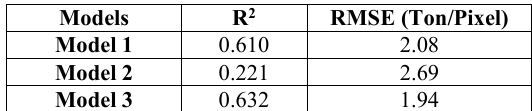
Figure 3. Correlation of Sentinel-1 predictor variables to field Table 4. Root Mean Square Errors (RMSEs) and Coefficient measured AGB.